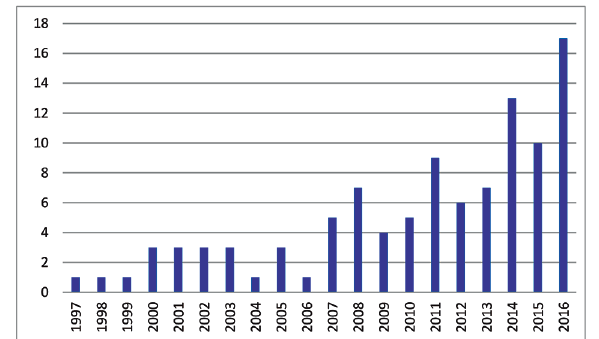
Figure 2. Number of related papers published between 1997 and